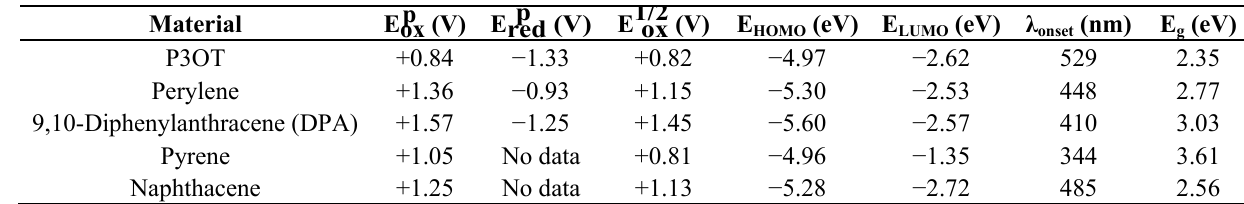
Table 2. Summary of electrochemical and photophysical characteristics of focused materials measured by cyclic voltammetry (CV) and ultraviolet-visible (UV-Vis) absorption spectra